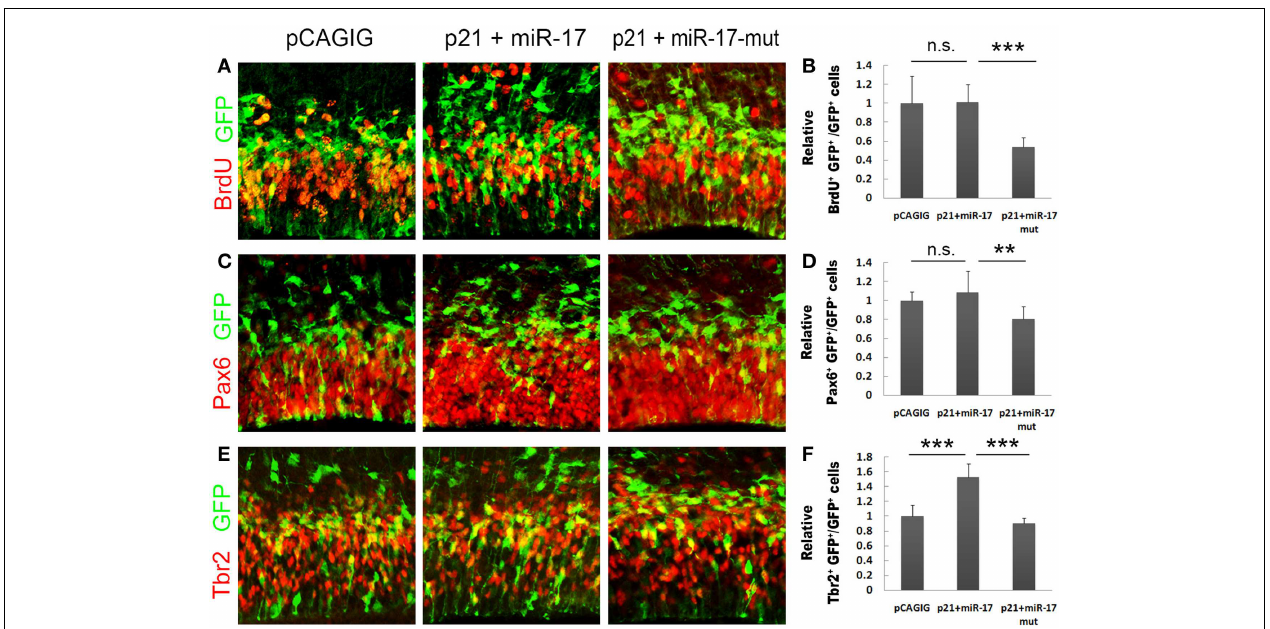
alone, while co-expression of a mutated miR-17 (miR-17-mut) with p21 ( n = 3) failed to do so. (E,F) Co-expression of miR-17 with p21 ( n = 5) significantly rescued the reduced number of IPs caused by p21 alone, while co-expression of a mutated miR-17 with p21 ( n = 3) failed to do so. Data are presented as mean ± SEM; n ≥ 3 in all constructs; p values in relation to the control (** p < 0.01, *** p < 0.001), n.s., not